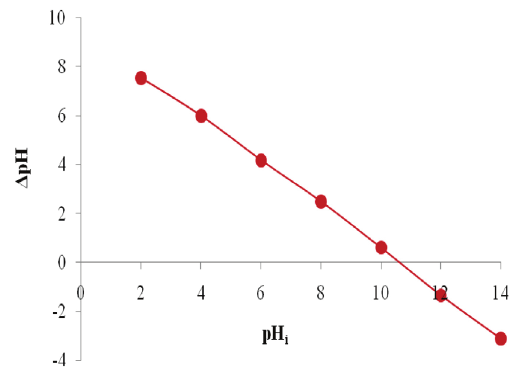
Fig. 7 – Determination of pH